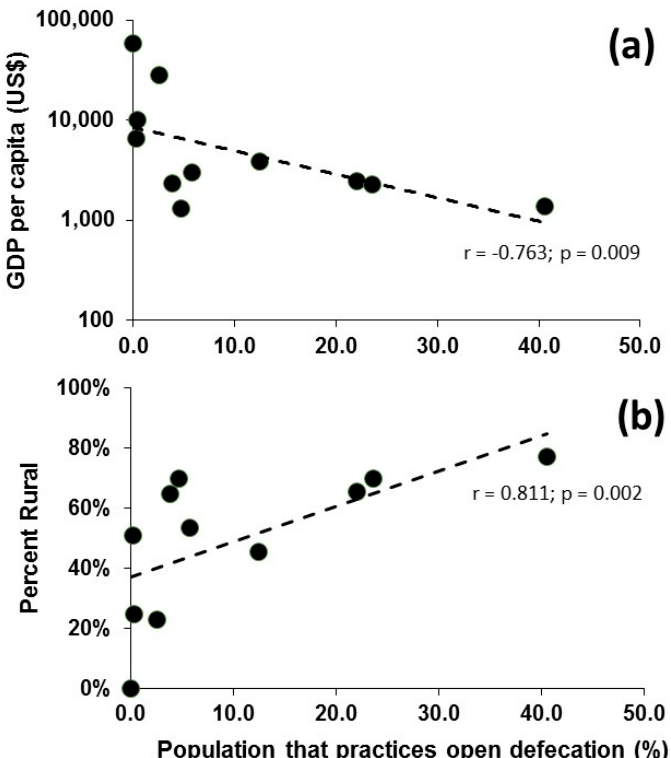
Figure 7. Relationships between the per capita Gross Domestic Product (GDP) [15] and percent rural population and percentage of the population that practices OD in the eleven SE Asian countries. ( a ) GDP and ( b ) percentage of rural population. Trendlines provided to help visualize the trends.